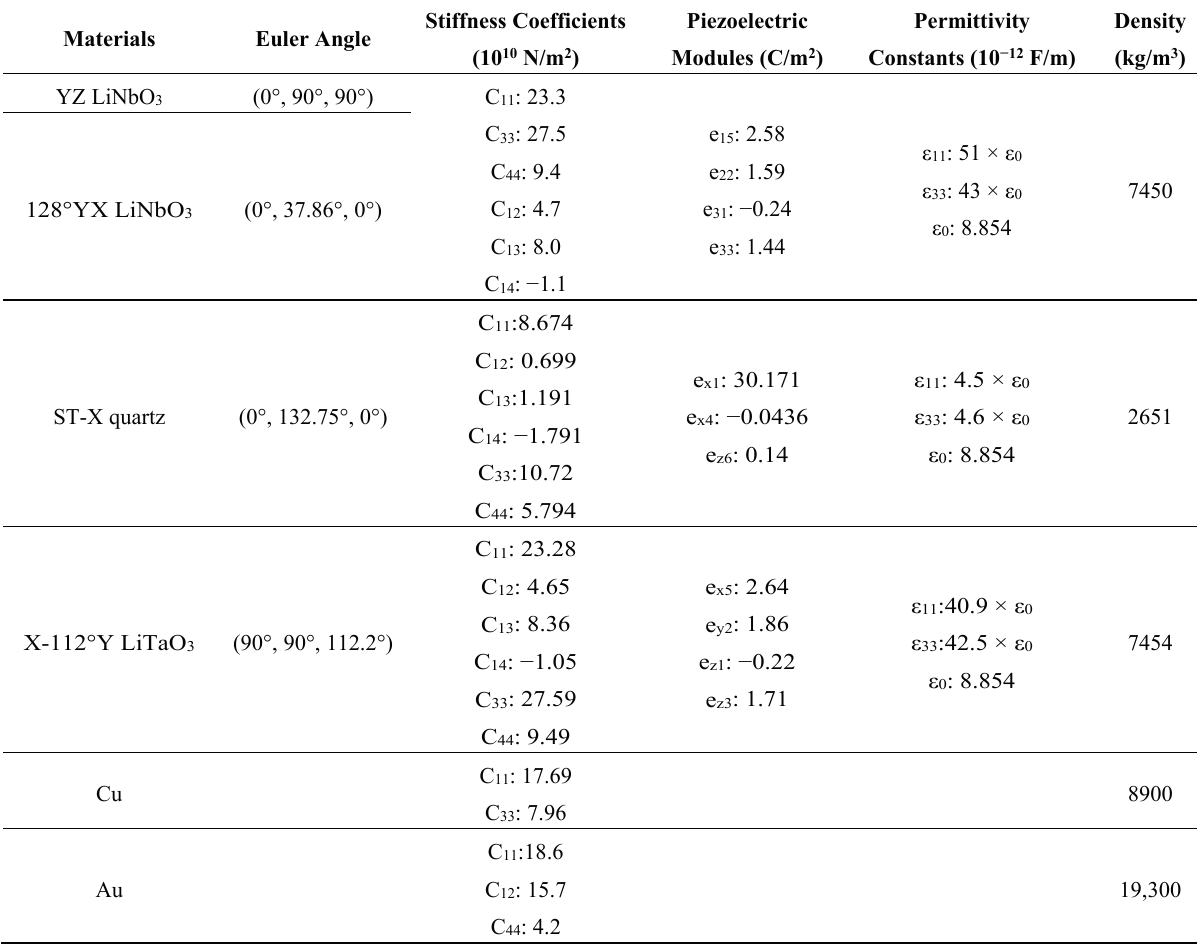
Table 1. Mechanical parameters for the piezoelectric substrate and metallic dots [13,14]. Materials Euler